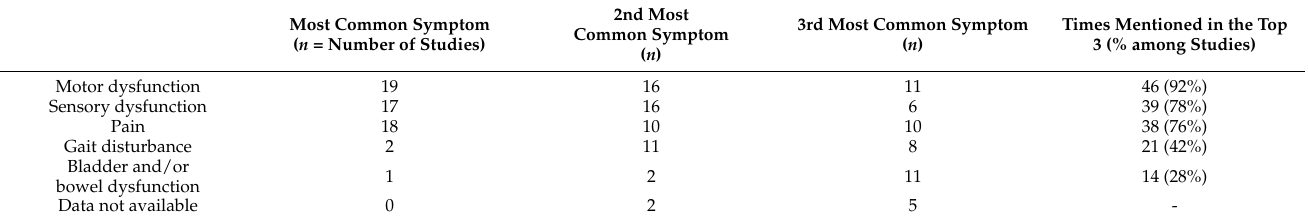
Table 2. Table showing the distribution of the three most common symptoms among the 50 studies where at least the most common symptom was